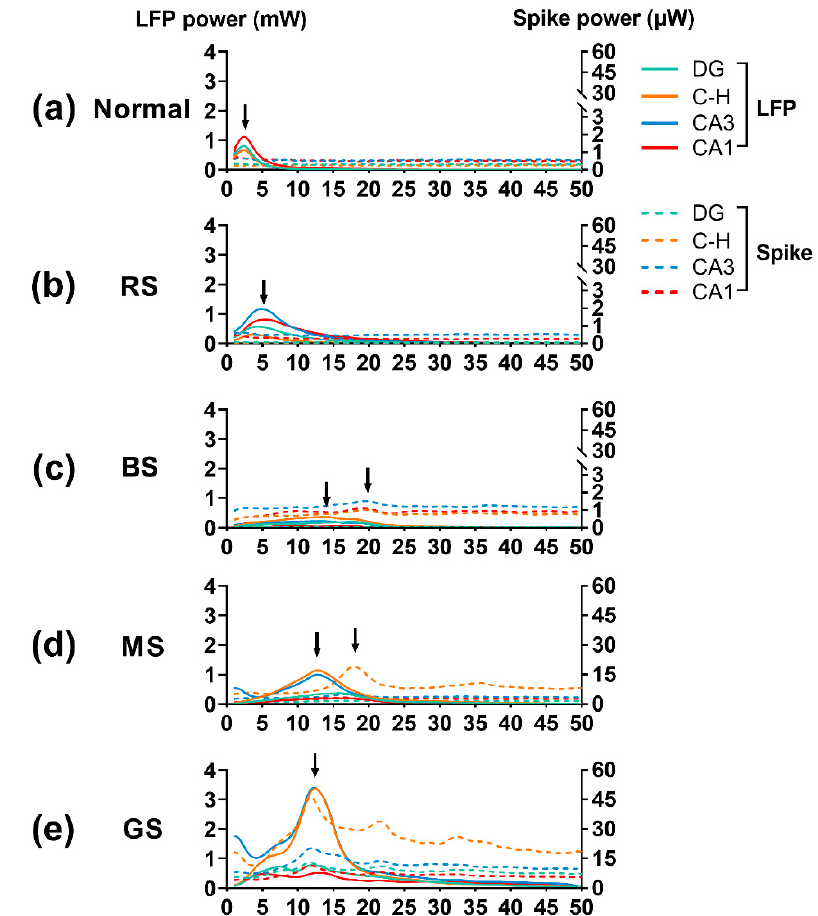
Figure 8. The joint analysis of power spectral density (PSD) of neural spikes and local field potentials (LFPs). ( a ) Normal stage. ( b ) Resting stage. ( c ) Beginning stage of seizure (BS). ( d ) Middle stage of seizure (MS). ( e ) Grand mal stage of seizure (GS). C ‐ H: hilus.